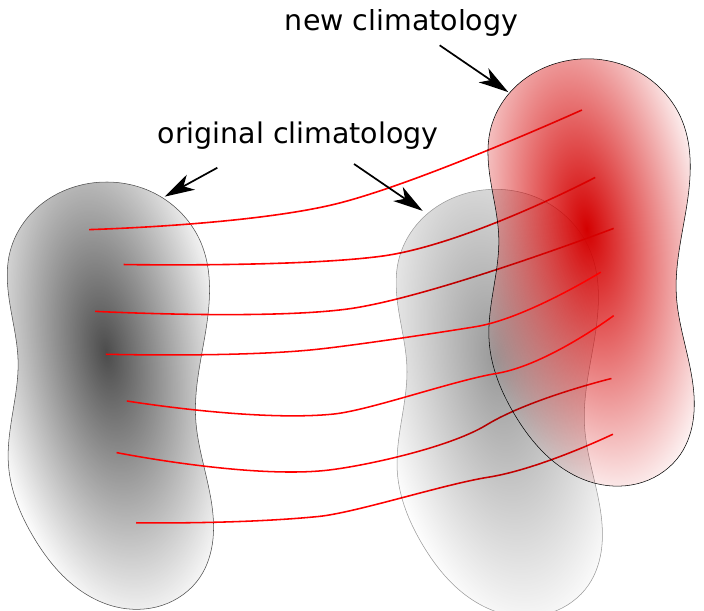
Figure 4. Climatology shifts in response to forcing. The climatological space of the target variable is represented by the grey region on the left. This region shifts in response to forcing to yield the red region on the right.